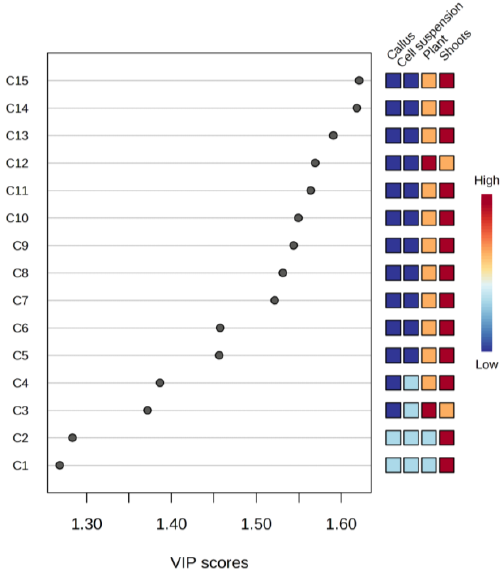
Figure 2. Variable importance in projection (VIP) scores plot (measure in PLS-DA), indicating